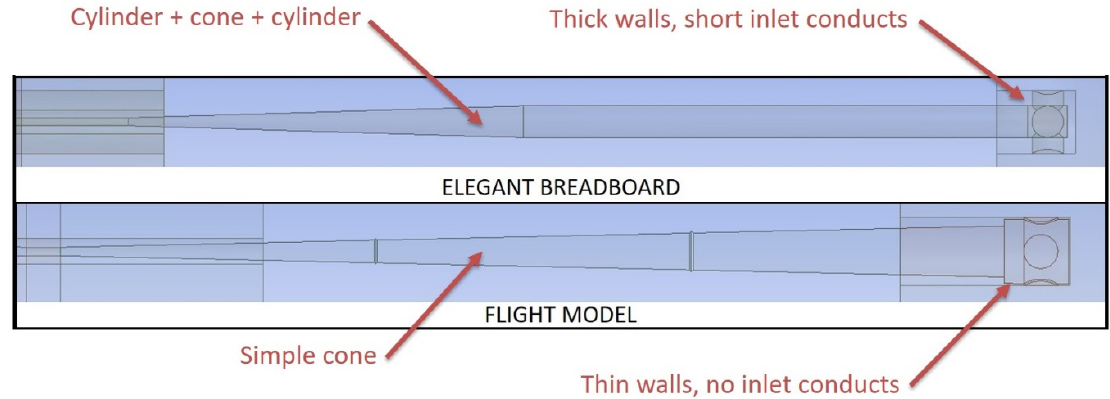
Figure 4. Geometry variations of MicroMED’s sampling head and inlet duct (drawings not to scale) .